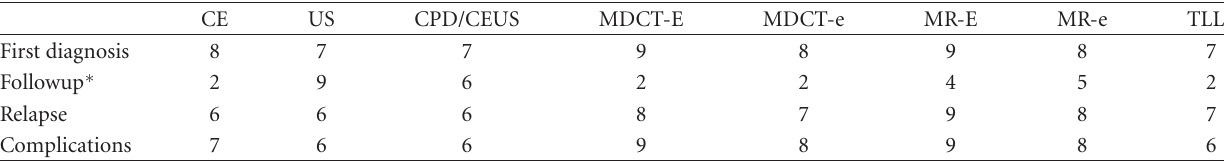
Table 3: Appropriateness of examination in Crohn’s